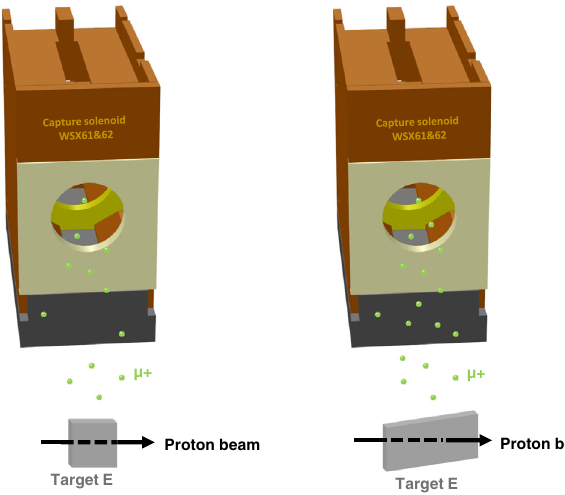
FIG. 3. The OTE, as shown on the left side, has been replaced by the NTE in November 2019, shown in the right figure. The two targets are designed to have the same effective length for the proton beam to ensure that energy loss, scattering, and the deposited power of the beam in the target remain unchanged while the new target has a larger surface producing more surface muons. In order to see the difference more clearly, both targets have been magnified